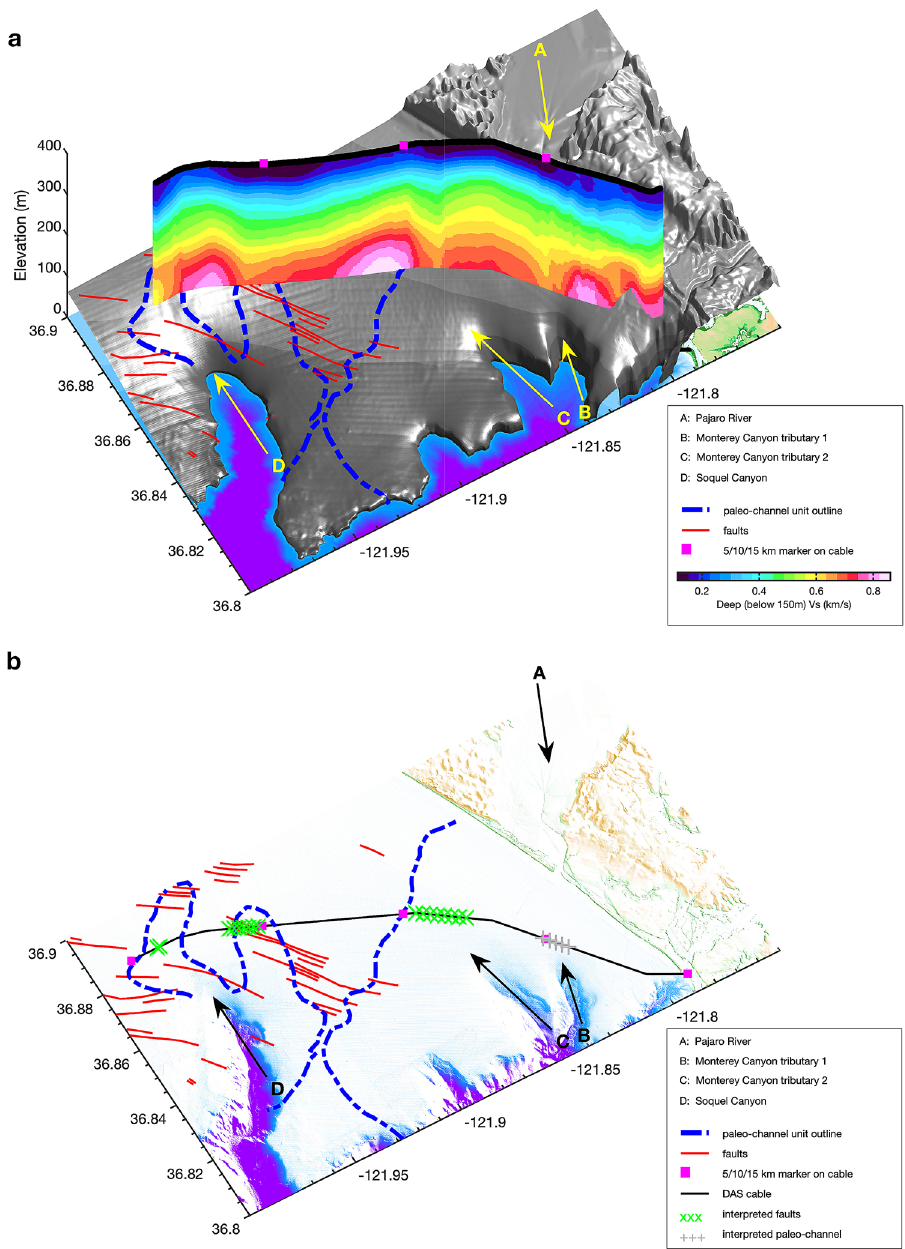
Figure 10. Integrated interpretation including submarine structural features. The vertical color image shows the inverted V s profile (Fig. 6); three pink squares on the V s profile indicate marks for cable locations (5 km, 10 km, 15 km); the red lines represent the mapped faults after 68 ; the blue dashed lines indicate the outline of paleo-channel units obtained from 37 ; text arrow A indicates the flow direction of Pajaro River; text arrow B and C annotate the tributary of the Monterey Canyon; text arrow D indicates the Soquel Canyon. The green crosses represent the interpreted fault zones around the cable; the gray crosses represented the interpreted paleo- channel